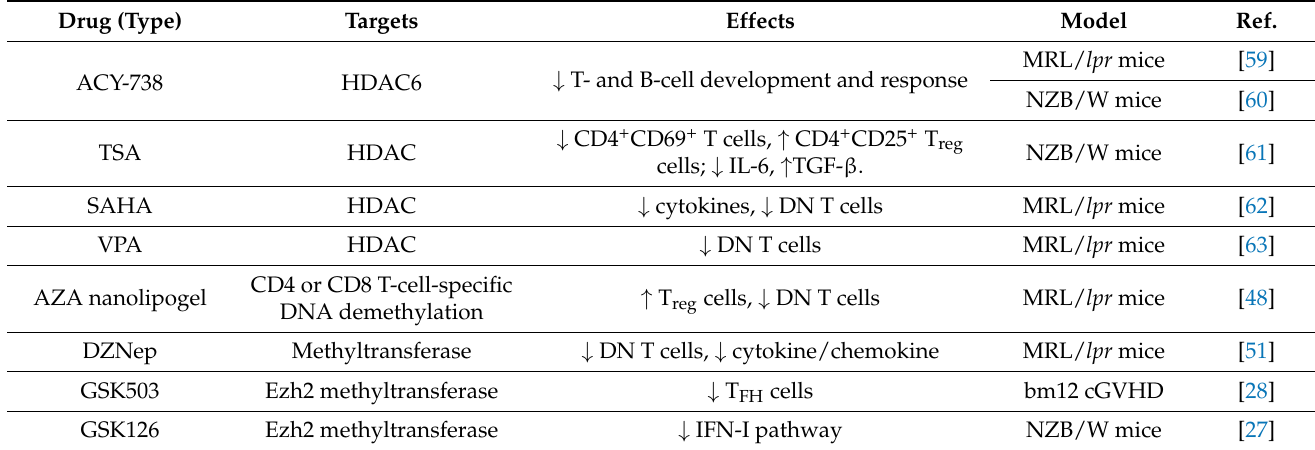
Table 1. Epigenetic therapeutics in mouse models of lupus and lupus